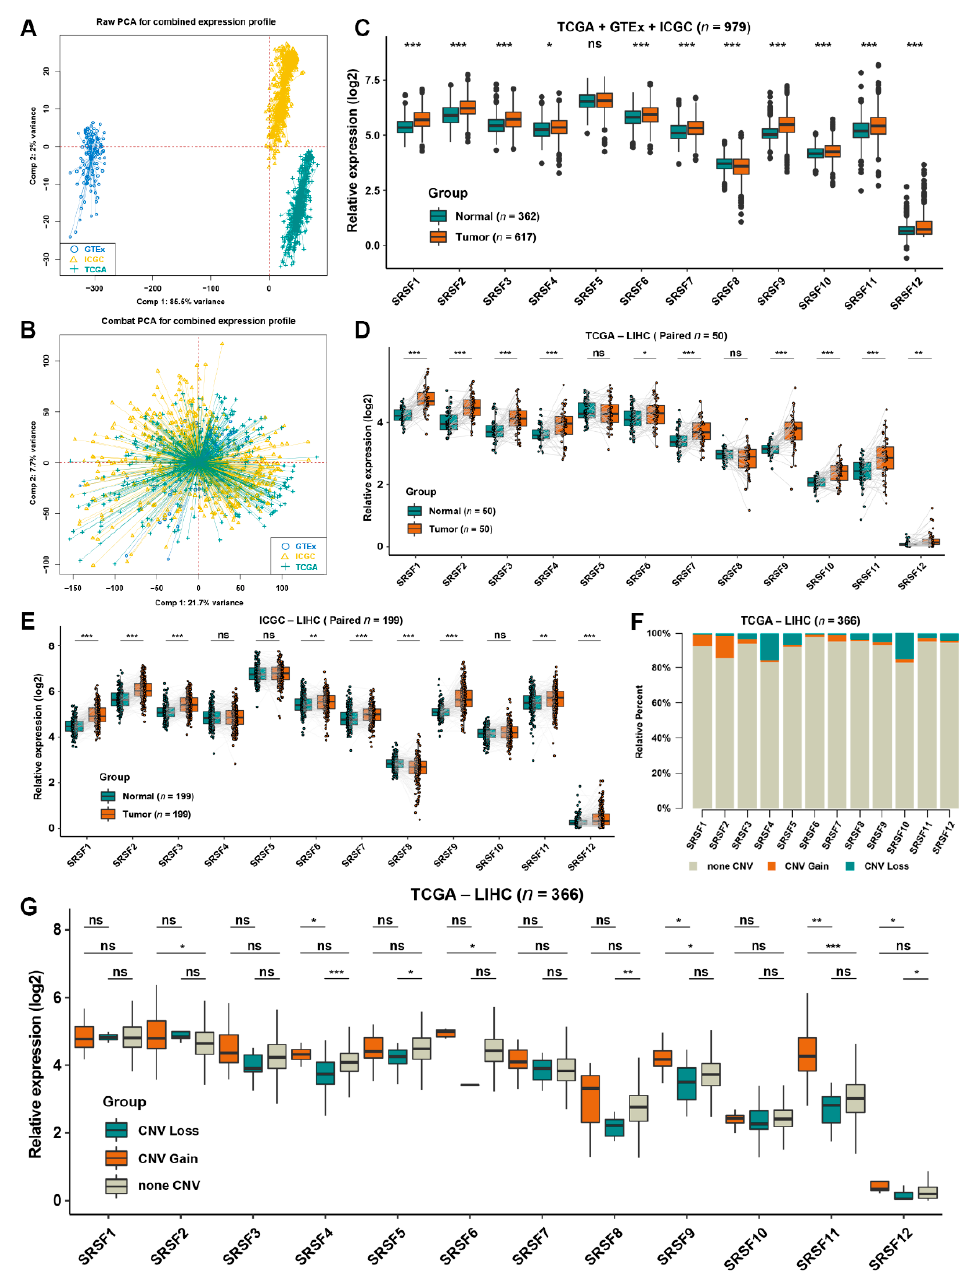
Figure 1. The expression pattern of SRSF family genes in HCC. ( A ) Principal component analysis (PCA) of the transcriptome profiles in distinct LIHC cohorts from the TCGA, ICGC and GTEx databases. ( B ) PCA of the transcriptome profiles of the aggregated HCC cohort. ( C ) The relative expression of 12 SRSF family genes in the aggregated HCC cohort. ( D , E ) The relative expression of 12 SRSF family genes in paired HCC and nontumor liver tissues from the ( D ) TCGA-LIHC and ( E ) ICGC-LIHC cohorts. ( F ) CNV of 12 SRSF family genes in HCC from the TCGA-LIHC cohort. ( G ) The relative expression of 12 SRSF family genes with different CNV states in the TCGA-LIHC cohort. The asterisks represent the statistical p -value (* p < 0.05, ** p < 0.01 and *** p < 0.001. ns, no significance).